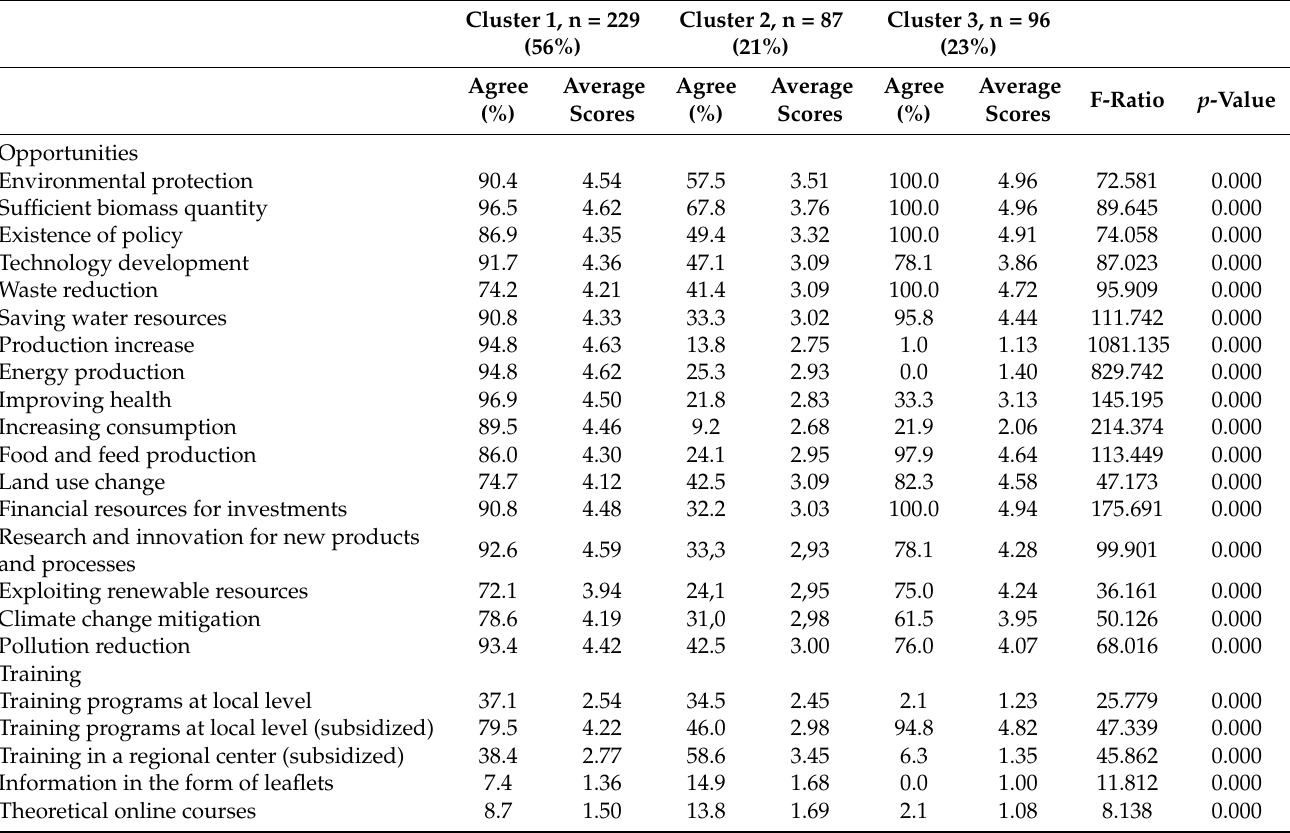
Table 6. Perceptions about opportunities and training in respect of the bioeconomy among clusters (percentage agreeing a and average scores b